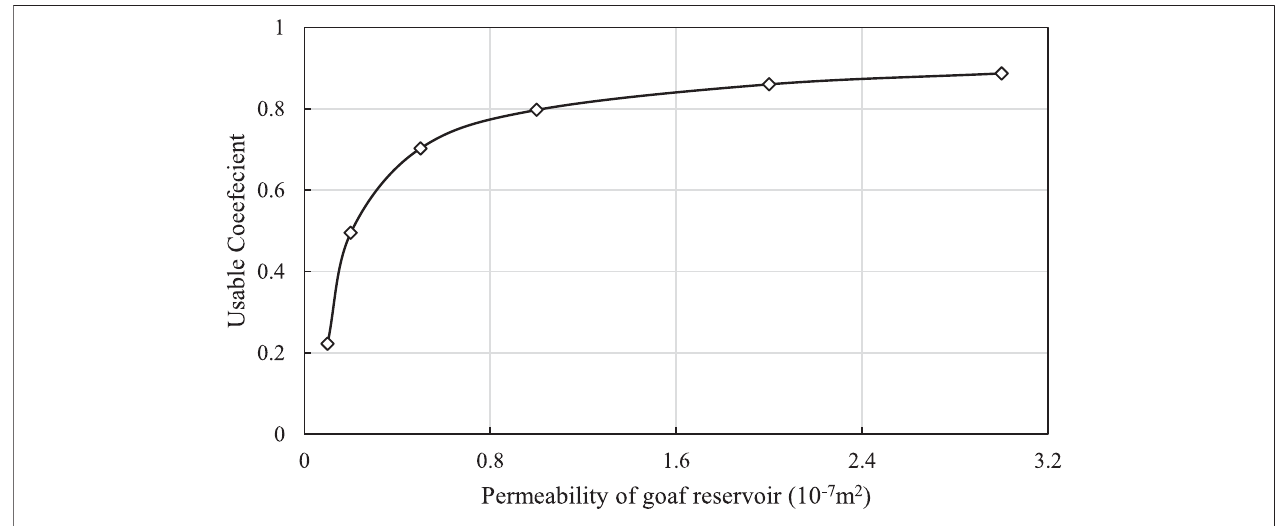
FIGURE 6 | Effective capacity coef fi cient of goaf reservoirs with varying goaf permeability.